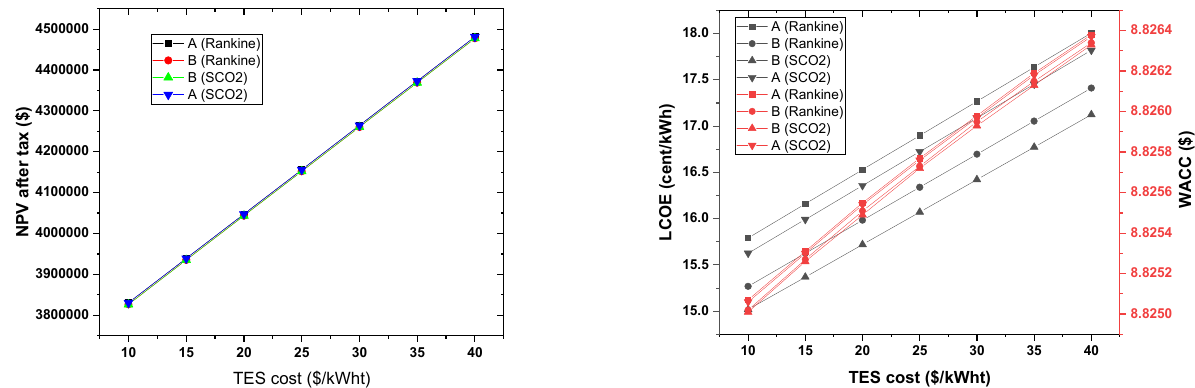
Figure 11. Effect of heliostat field cost on some metrics for the various scenarios, ( a ) NPV ( b ) LCOE and IRR. The effect of TES cost on the viability of the various scenarios are represented in Figure 12. According to the results, the effect of TES cost is insignificant on the weight average cost of capital (WACC), as it remained virtually constant under varying TES costs. However, both NPV and LCOE increase significantly with increasing TES cost.